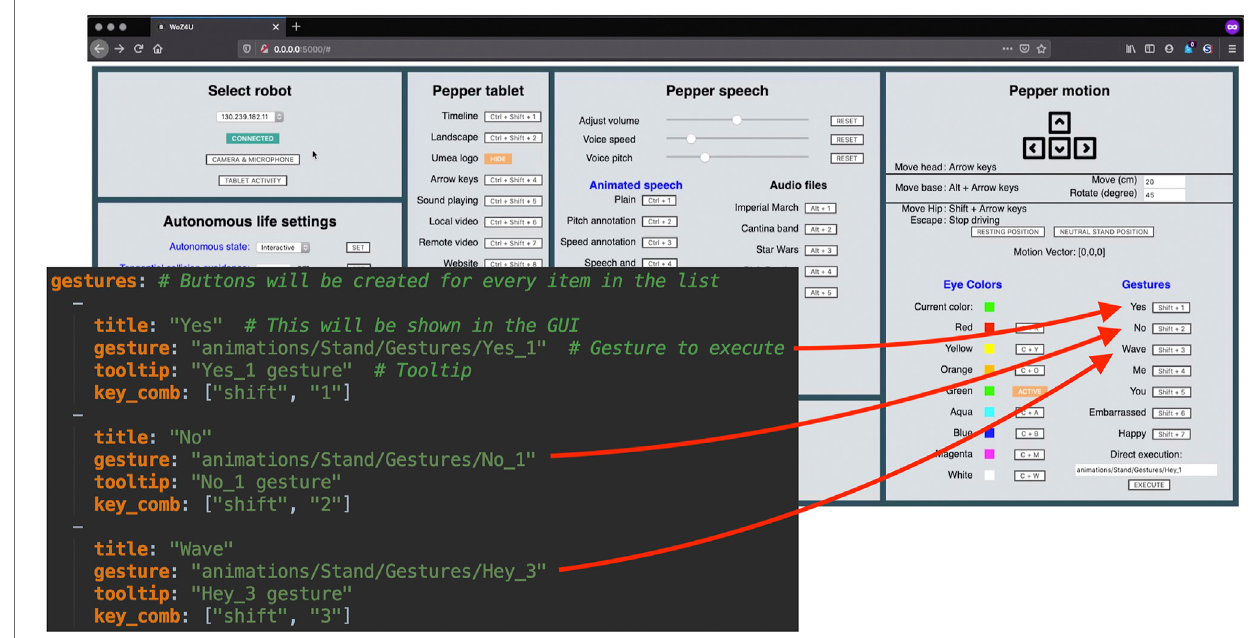
FIGURE 4 | Illustration of how items in the con fi guration fi le control the appearance of the GUI.